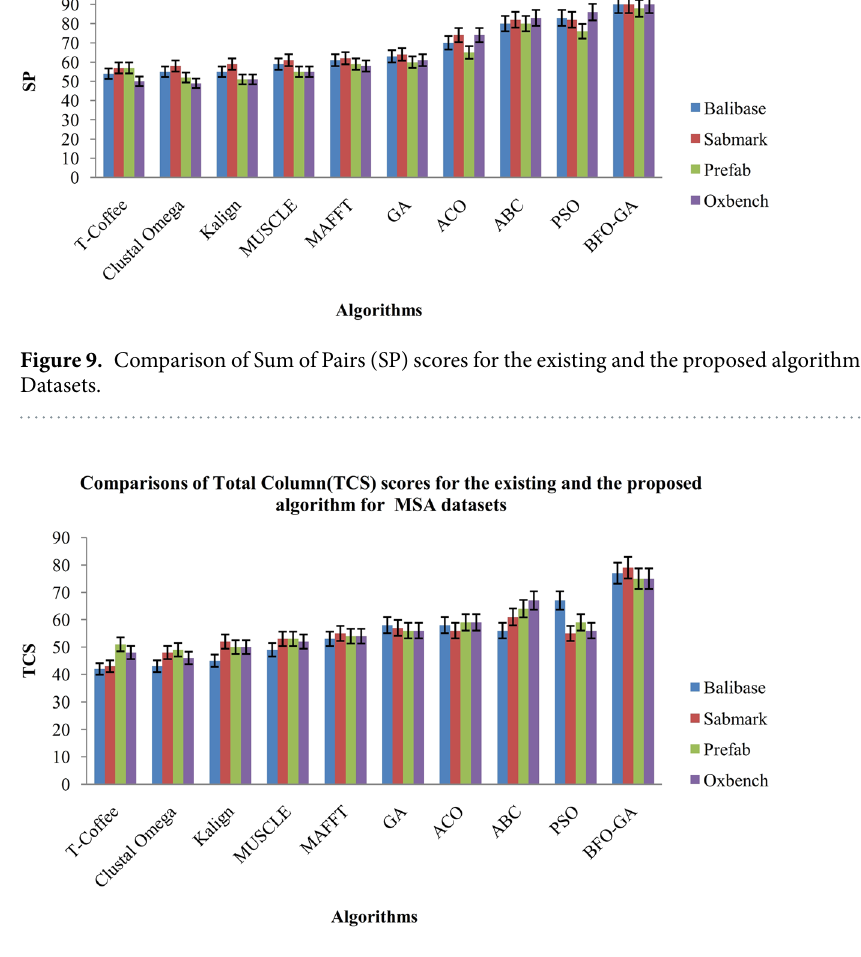
Table 1. Statistical significance of proposed and existing algorithms for MSA benchmark